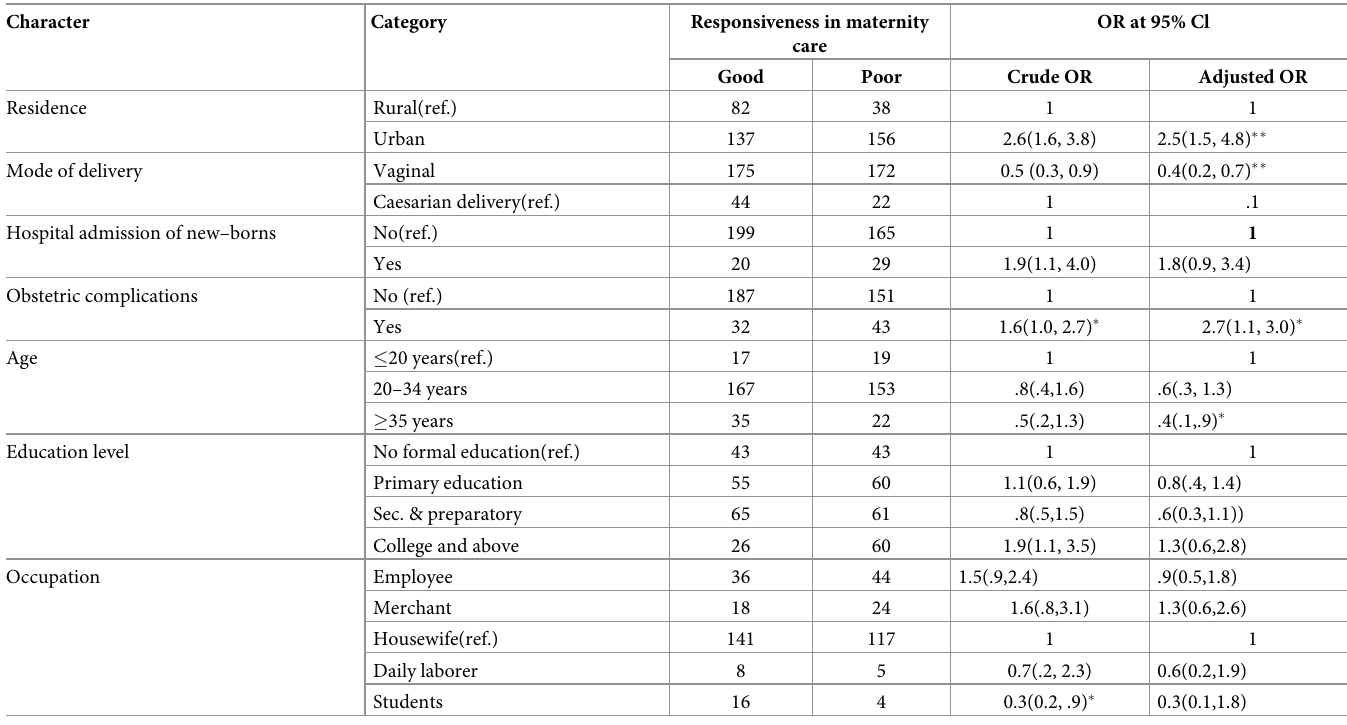
Table 3. Factors associated with poor responsiveness in maternity care of Hadiya zone public hospitals, July